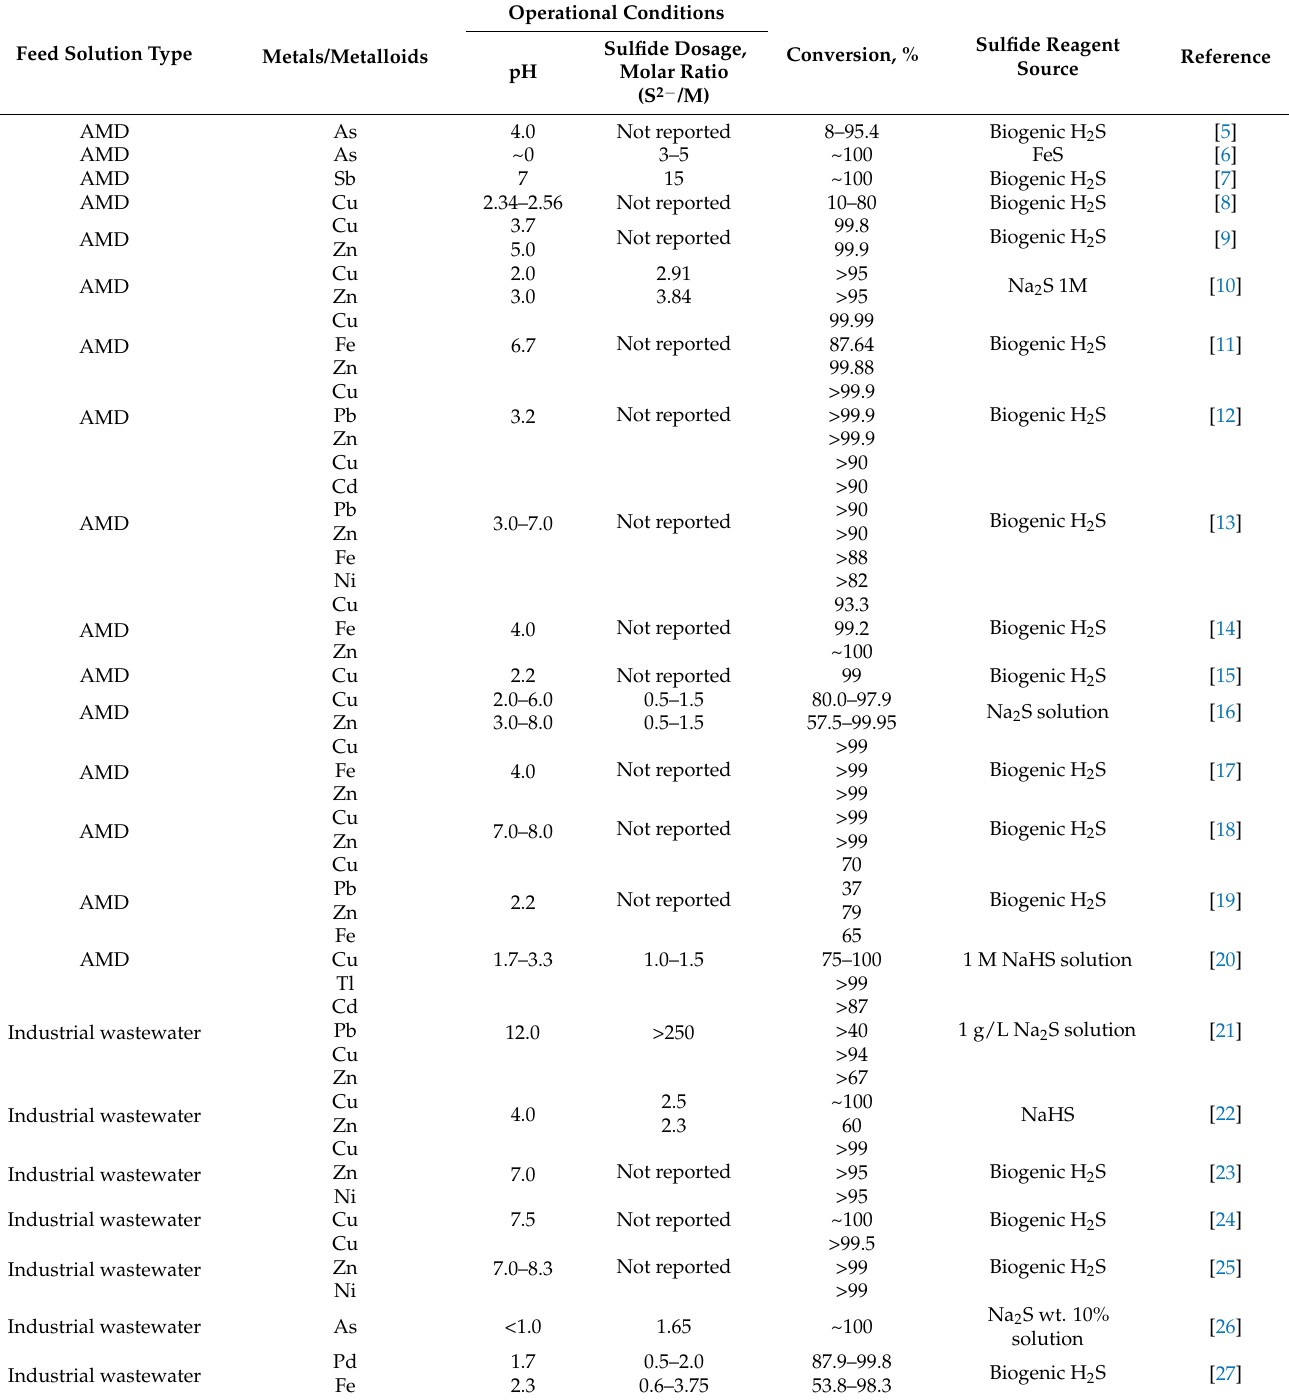
Table 2. Summary of applications for the metal sulfide precipitation process for different feed solutions and met-